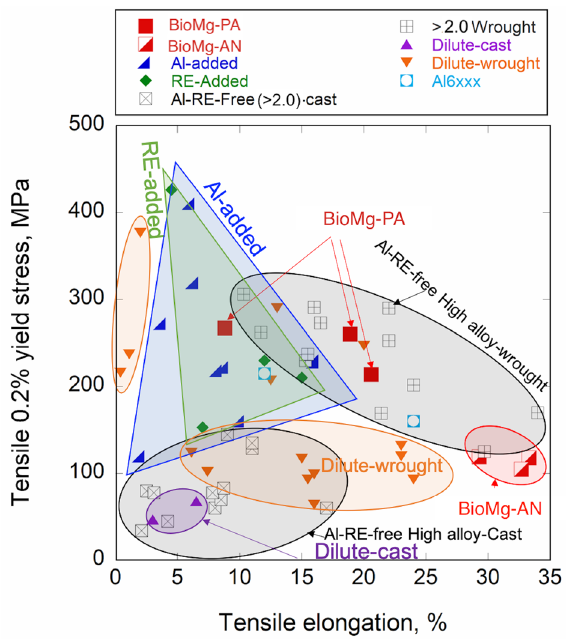
Figure 4. Plot compares the 0.2% tensile yield versus elongation for the present dilute Mg alloy with many other types of Mg-based alloys in the literature 3,8–16,26,27,42,47–62